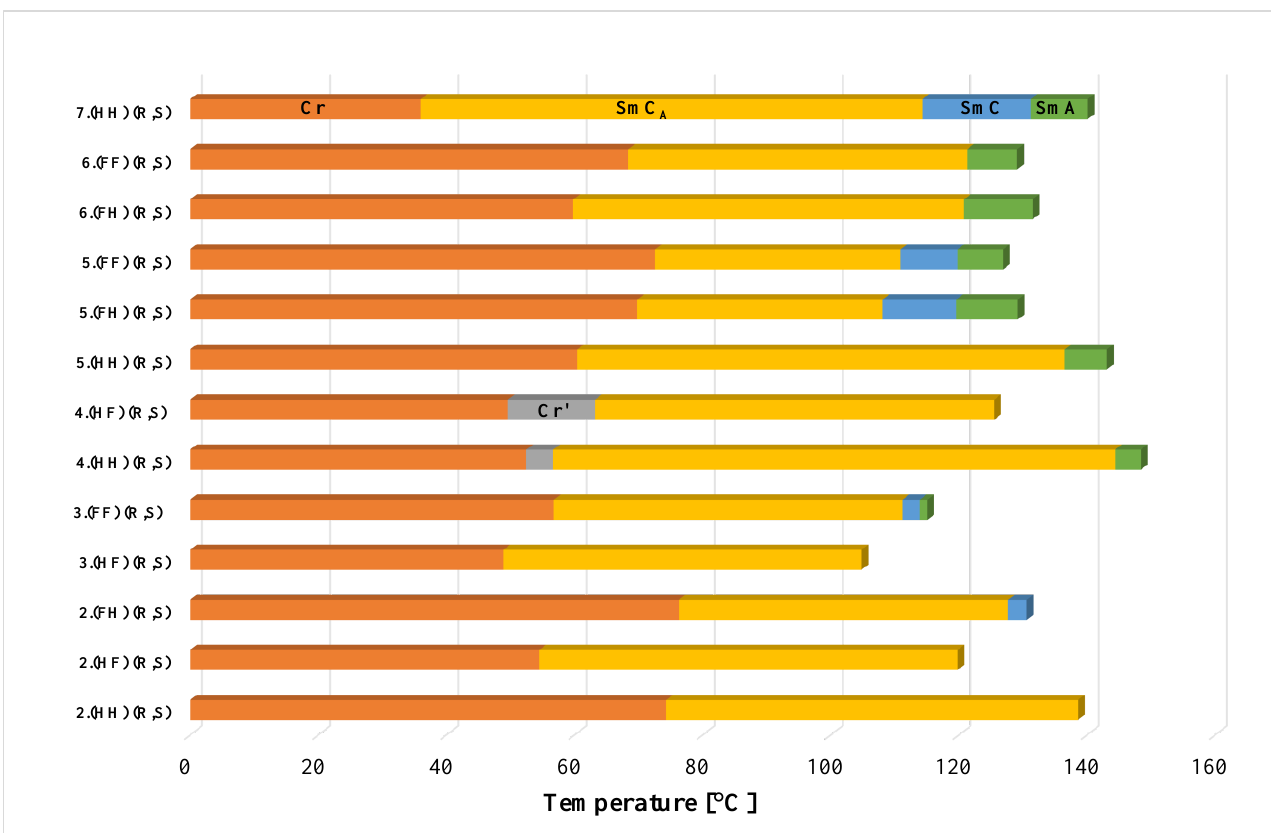
Figure 3. The temperature ranges of the phase transitions (from DSC measurements) for the racemic mixtures observed in the heating cycle.